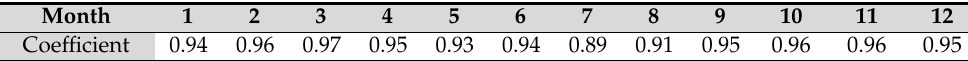
Table 2. Pearson correlation coefficients of monthly irradiance and SPV power